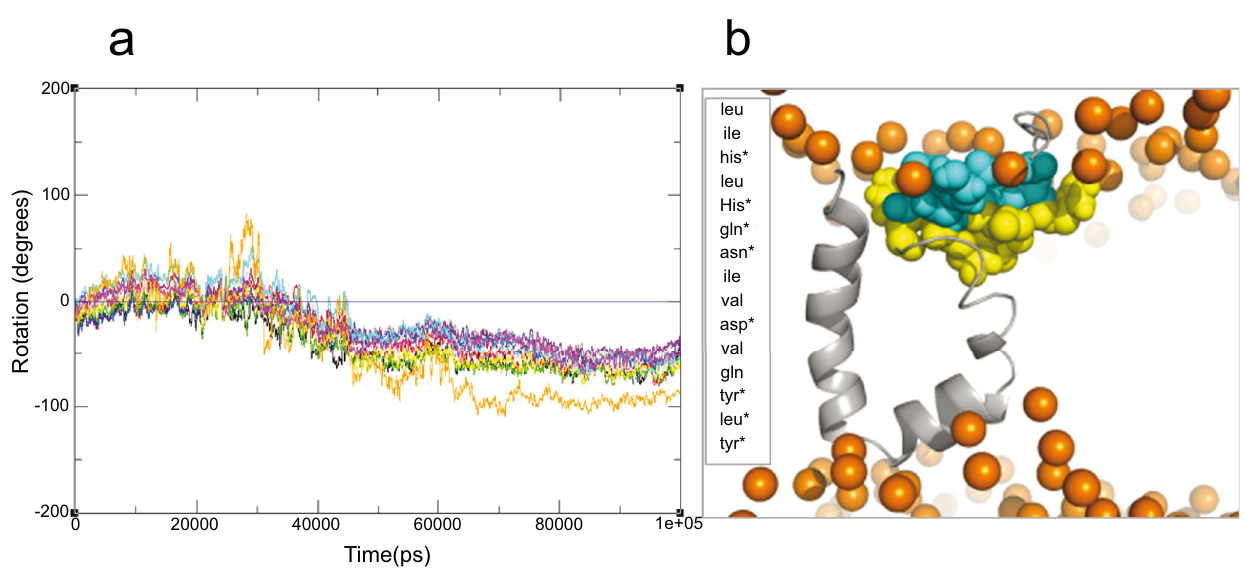
Supplementary Figure 3. Residue rotation of I-Tasser model. ( a ) Synchronized rotation was observed, convergence was also observed at around 50 ns and the remaining of the simulation time. ( b ) Residues pointing to hydrophilic regions are denoted with asterisks and colored in cyan and residues pointing to hydrophobic regions are colored in